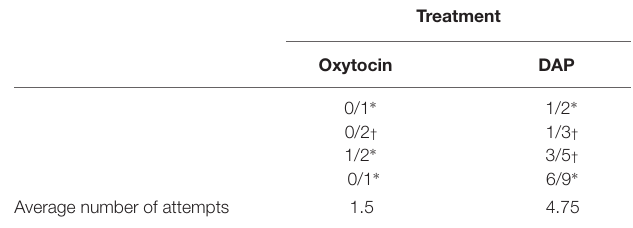
TABLE 6 | Raw correct scores (out of total choices made by dog) for dogs that chose at least once but less than 10 times in the object choice task according to treatment group.